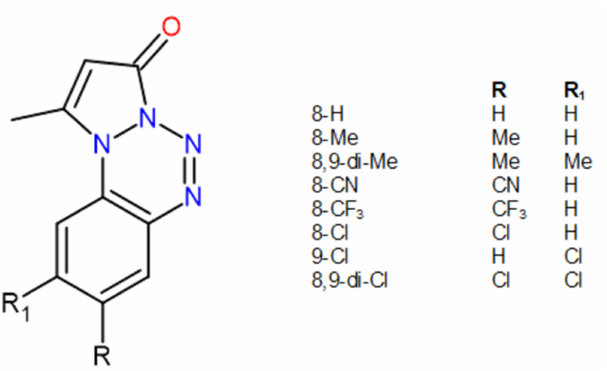
Figure 1. Structure of the investigated pyrazolo[1,2-a]benzo[1,2,3,4]tetrazin-3-one derivatives